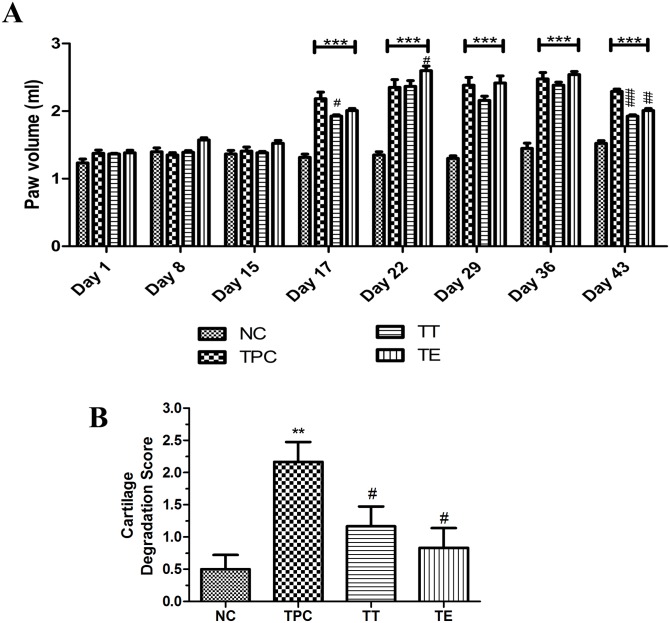
Paw volume and cartilage degradation scoring of therapeutically treated groups.(A) Paw volume changes in therapeutically treated rat groups from day 1–43 (values analyzed using RM-ANOVA with Graph Pad prism; "***" indicates significant difference compared to negative control (NC) (P<0.001); "#" indicates significant difference compared to therapeutic positive control (TPC) (### represents P<0.001, ## represents P<0.01 and # represents P<0.05); values represented in Mean ± SEM, n = 12. (B) Cartilage degradation scores from histomorphological sections of therapeutically treated groups; "**" indicates significant difference compared to NC (P<0.01); statistically significant differences between TPC and TT or TE groups indicated as "#" (P<0.05); values represented in Mean ± SEM, n = 6.